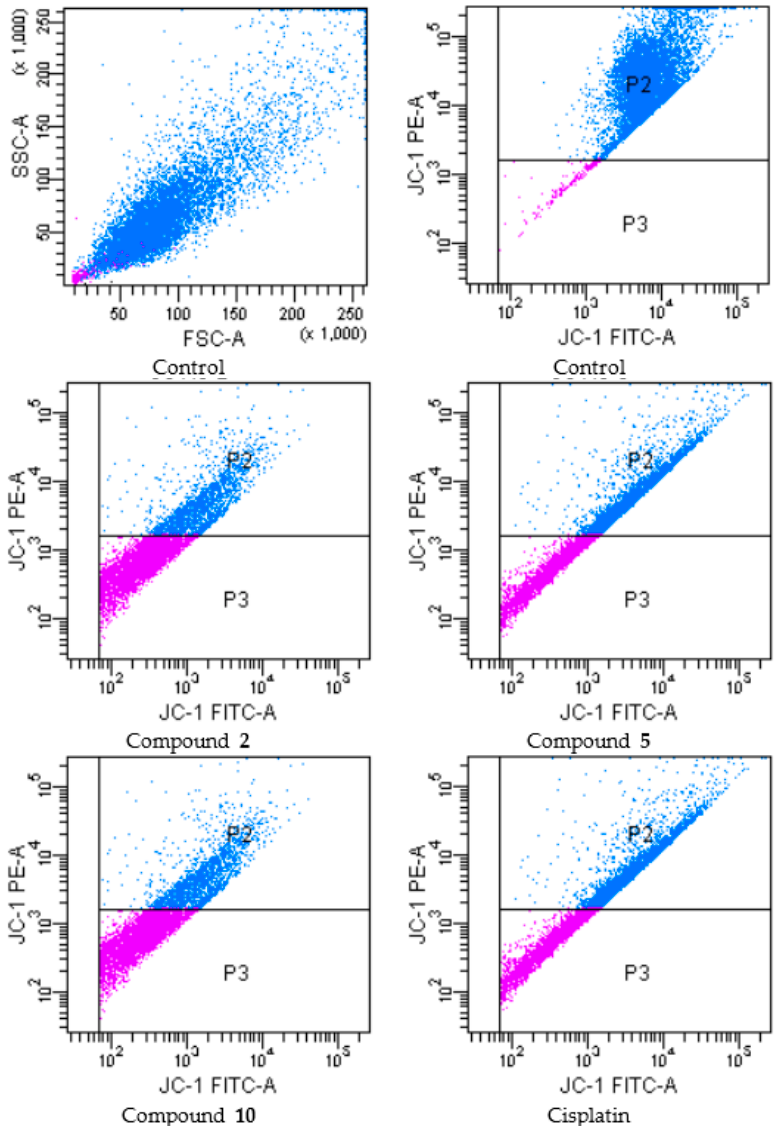
Figure 5. The reduction of the mitochondrial membrane potential in C6 cell line by the compounds. The cells treated or untreated with the IC 50 doses of the compounds for 24 h were stained with the mitochondrial-selectivite JC-1 dye and analyzed by flow cytometry. P2: mitochondrial membrane polarized cells, P3: mitochondrial membrane depolarized cells.